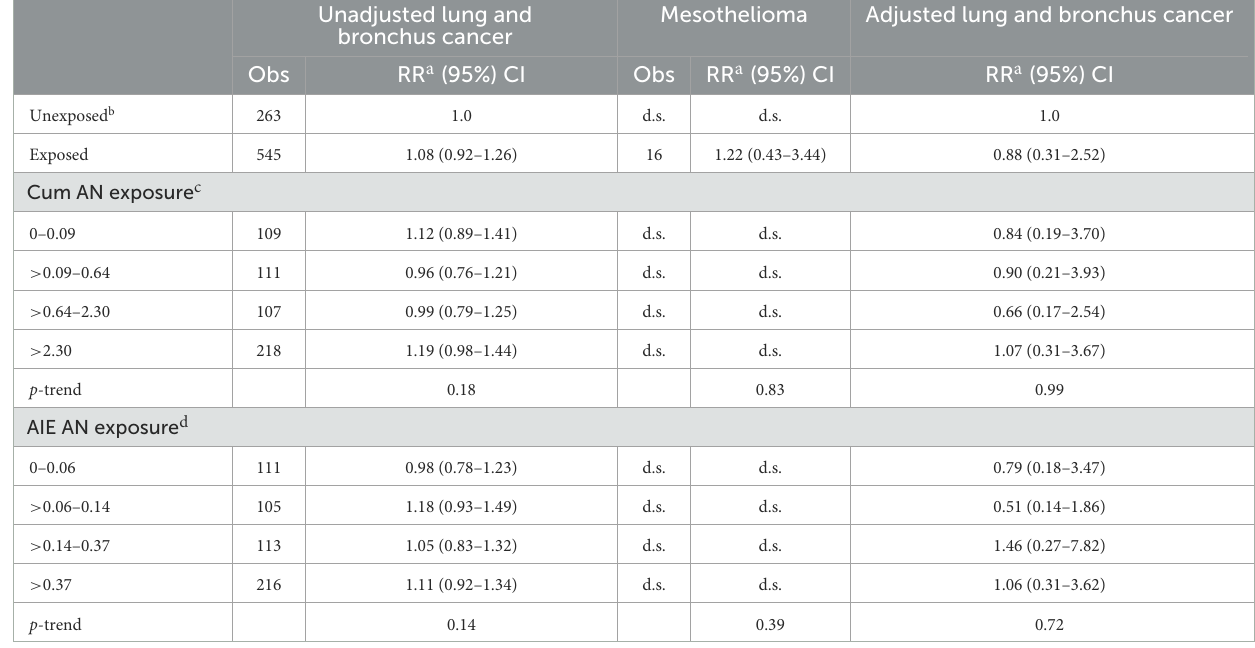
TABLE 5 UPitt lung and bronchus cancer relative risks (RR) in relation to AN exposure adjusted for potential confounding by asbestos using the Richardson method, full cohort, 1942–2011. Unadjusted lung and Mesothelioma Adjusted lung and bronchus bronchus cancer